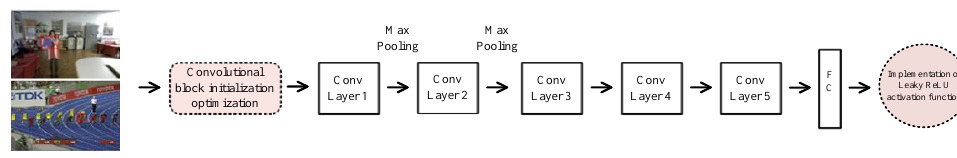
Figure 7. Proposed convolutional block initialization optimization and activation function.